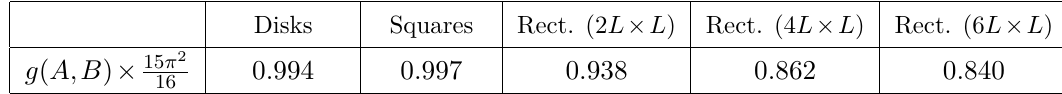
Table 1 . Continuum values of the coefficient g ( A, B ) normalized by the analytic result correspond- ing to a pair of disks, 16 / (15 π 2 ) , obtained in the lattice for different pairs of identical regions. we find the